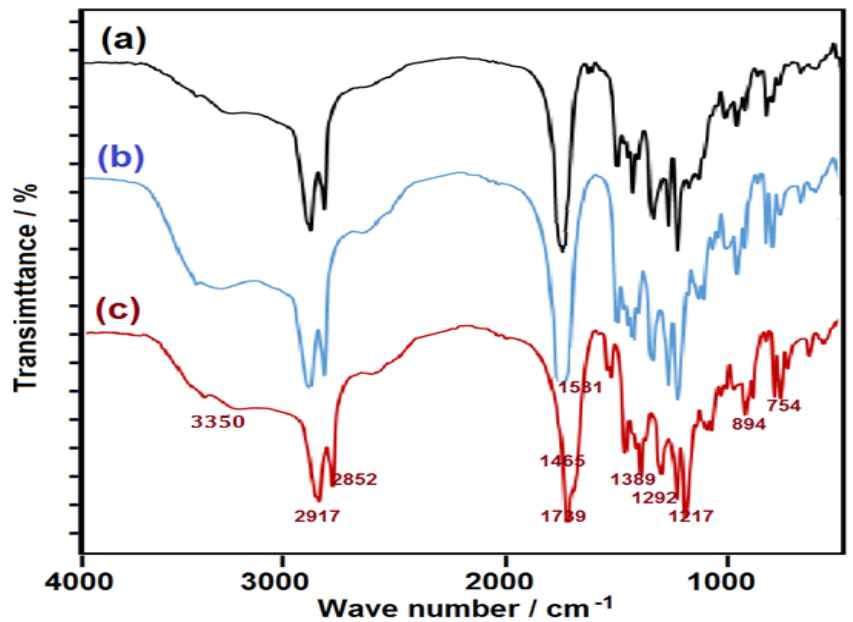
Figure 2. FTIR charts of ( a ) PES, ( b ) PES-WO 3 NC, and ( c ) PES-ZnO NC composites . XRD plots (Figure 3) for PES, WO 3 -PES NC, and ZnO-PES NC reveal the presence of multiple diffraction patterns observed. The reflections of the crystalline structure were recorded in the 2 θ range of 6–45 ◦ . The characteristic crystalline peaks appeared at around 2 θ = 6.06 ◦ (30.4%), 21.75 ◦ (100%), and 24.64 ◦ (57.12%). The exposed value at 2 θ = 21.75 ◦ is correlated to the high content of the ester series. Medium appearance at 2 θ = 6.06 ◦ was due to rough form. The PES backbone contains prolonged polymer chains referring to various arrangements of polyester bindings [55]. ASTM 24-1148 and ASTM 89-0598 were reported in the diffraction plots of WO 3 and ZnO. Otherwise, the characteristic strong and sharp diffraction peaks reveal the good crystallinity of the composites of PES-WO 3 NC and PES-ZnO NC. The characteristic peaks at 2 θ = 6.0 ◦ , 13.4 ◦ , 20.4 ◦ ,21.7 ◦ , 24.5 ◦ , 29.8 ◦ , 30.6 ◦ , 38.8 ◦ , and 41.5 ◦ are related to the (020), (120), (032), (131), and (220) patterns of PES (JPDS: 04-0783). The high intensity and narrow peaks are detected at 2 θ = 6.0 ◦ , 7.2 ◦ , 21.7 ◦ ,21.9 ◦ , 24.6 ◦ , 24.7 ◦ , 30.6 ◦ , 38.8 ◦ ,41.7 ◦ , and 45.4 ◦ are correlated to the (020), (020), (200), (120), (111), (120), (131), (200), (202), and (222) crystalline planes of the spherical phase of WO 3 (JPDS: 43-0679). The strongest diffraction peaks observed at 2 θ values of 5.9 ◦ , 8.0 ◦ , 11.4 ◦ , 17.3 ◦